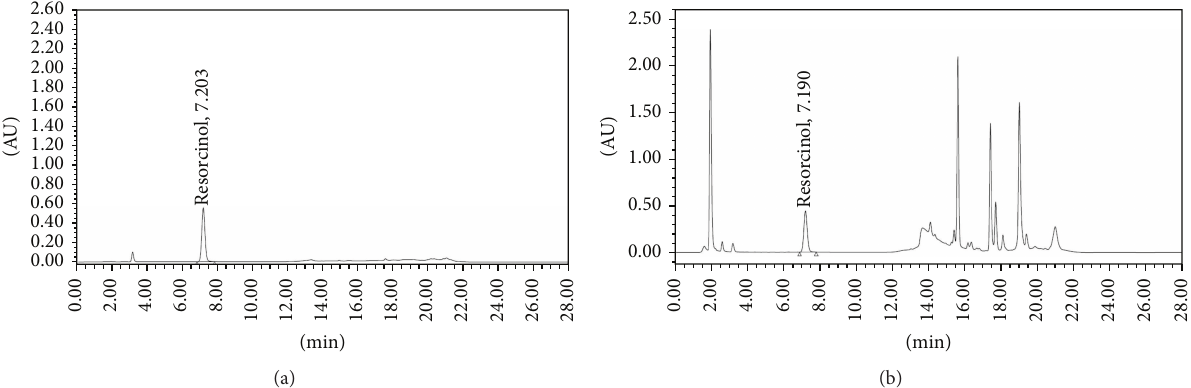
Figure 3: Representative chromatograms for resorcinol standard (a) and sample (b).